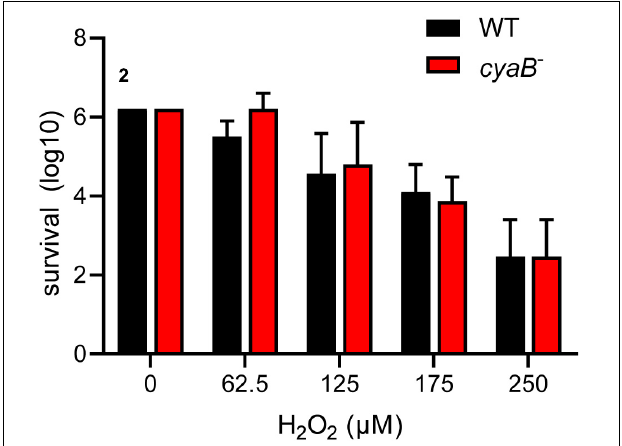
FIGURE 3 | cyaB does not contribute to H 2 O 2 resistance. WT and cyaB − strains were grown in BSK-glycerol to mid-log phase at 32 ◦ C 1% CO 2 , exposed to H 2 O 2 in modified BSK media for 4 h at 32 ◦ C 1% CO 2 , and serial diluted for outgrowth to determine survival. Shown are the average and standard error of three independent biological